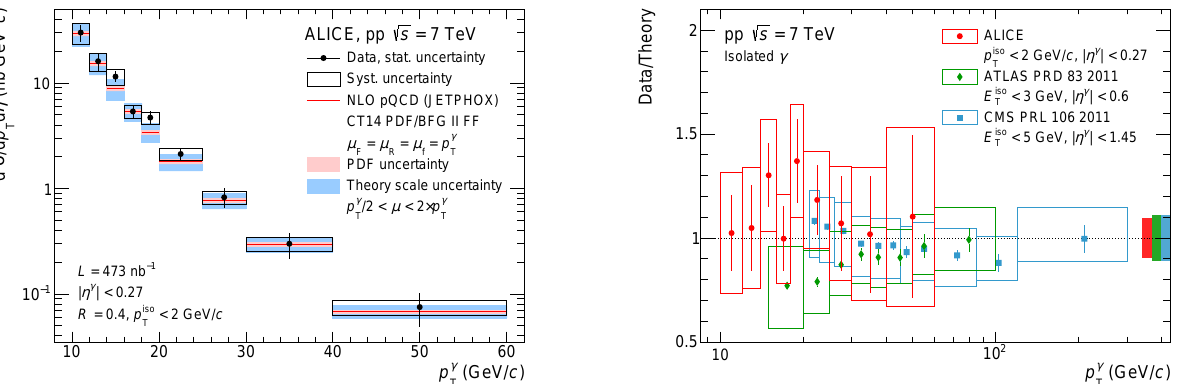
Figure 2. Left plot: Isolated photon differential cross section measured in pp collisions at √ s = 7 TeV [4]. Error bars represent statistical and boxes represent systematic uncertainties. The bands correspond to pQCD calculations with JETPHOX. Right plot: Ratio between differential cross section measurements and theory predictions for ATLAS [2], CMS [3] and ALICE [1]. Error bars are statistical and boxes are the quadratic sum of statistical and systematic uncertainties. The normalisation uncertainty of each experiment is presented as an overall box around unity.